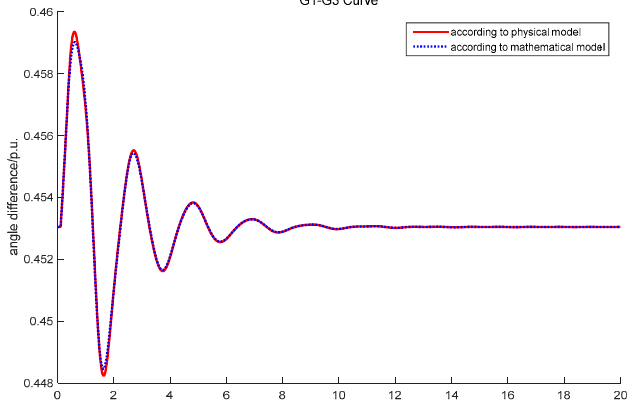
Figure 7. Comparative simulation curves of the G1–G3 angle difference according to the different models of data-loss.